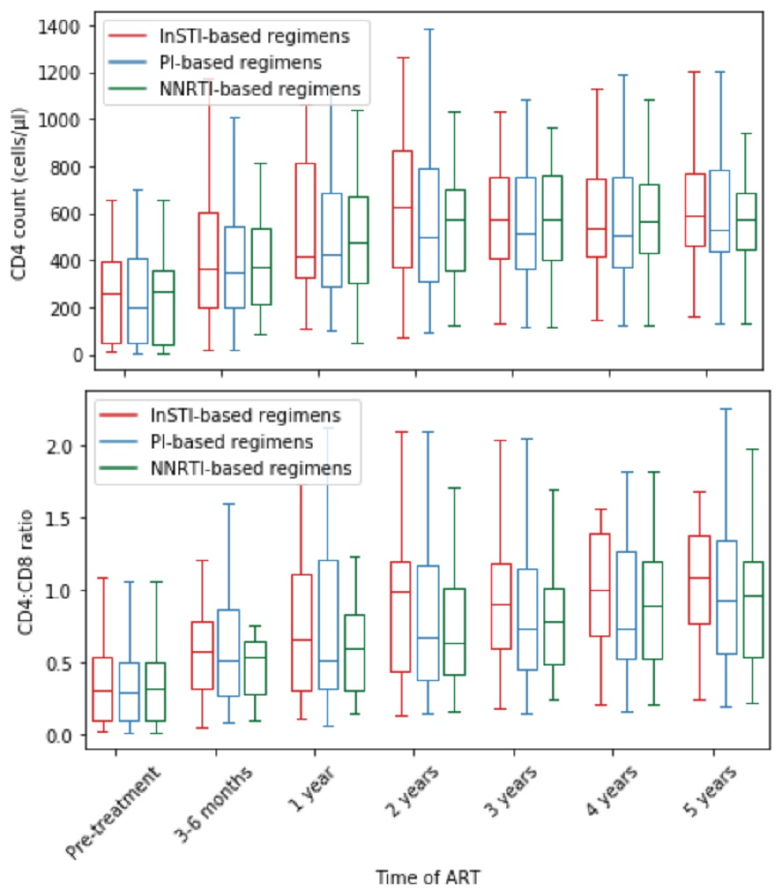
Figure 5. CD4 cell count and CD4:CD8 recovery depending on the applied ART regimen. We also evaluated whether the changes in the antiretroviral treatment regimen had an impact on CD4 cell count and CD4:CD ratio increase and CD4 count and CD4:CD8 ratio normalization. The results of CD4 cell count and CD4:CD ratio increase are shown in Table 8. The results of CD4 cell count and CD4:CD8 ratio normalization are presented in Table 9. Table 8. CD4 cell count and CD4:CD8 recovery depending on changes in the ART regimen. Variable